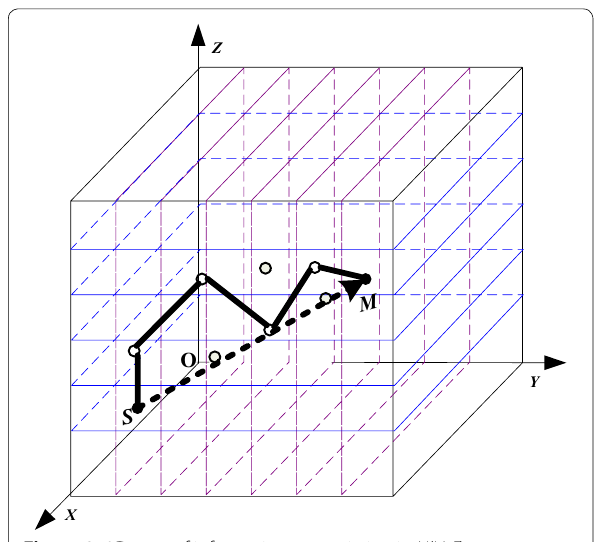
Figure 3 3D map of information transmission in N ( V , E